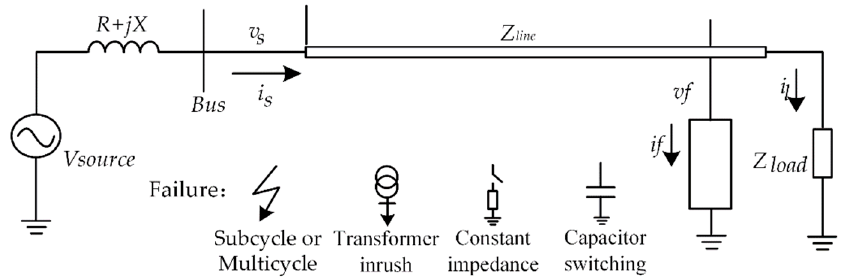
Figure 4. Simulation model of incipient cable failure and the overcurrent interference signals.